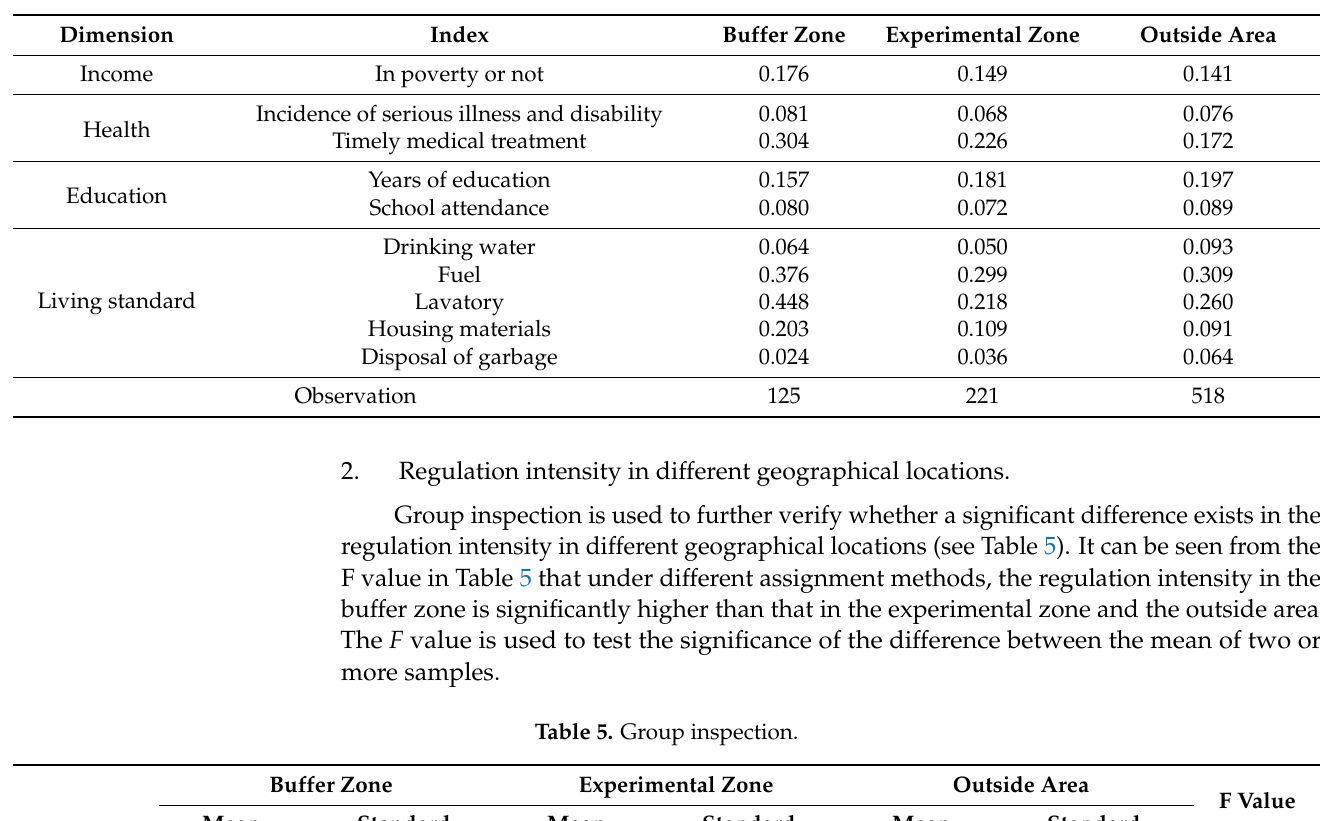
Table 4. Incidence of poverty under multidimensional indices for farmers in different geographical locations.